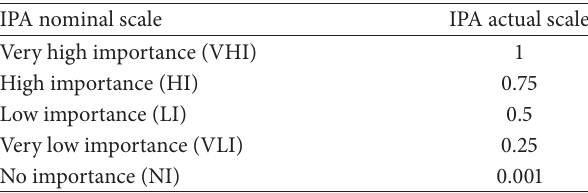
Table 2: IPA nominal scale and IPA actual